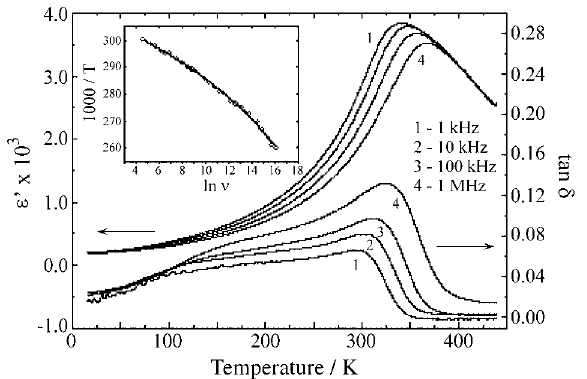
Figure 7. PLZT 10/65/35 dielectric constant ( ε ’) and dielectric losses (tan δ ) as a function of both temperature and frequency. Inset: Vogel-Ful- cher